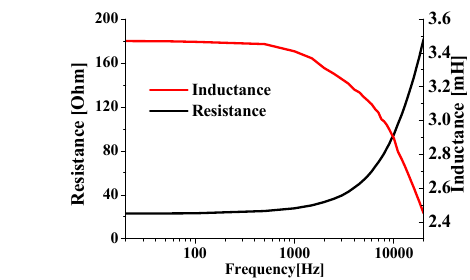
(b) Resistance and inductance of BA receiver(a) Resistance and inductance of dynamic receiver Figure 4. Calculated resistance and inductance Figure 4. Calculated resistance and inductance. Figure 4. Calculated resistance and inductance